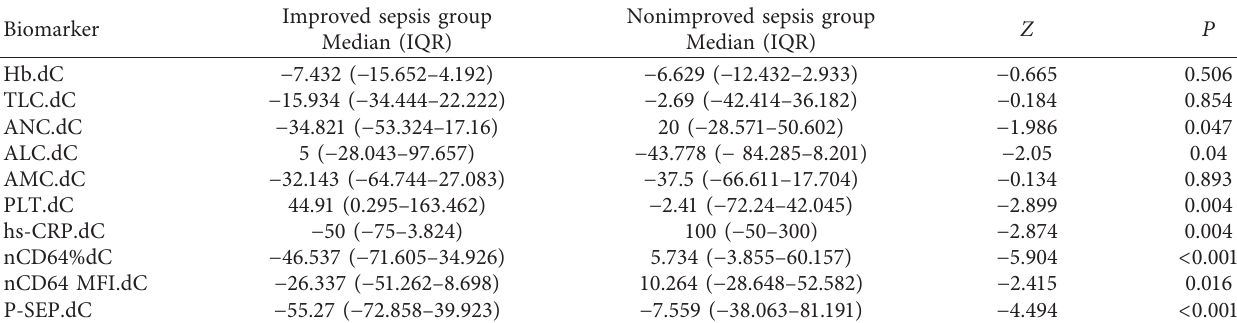
Table 7: Delta change percentage for both follow-up